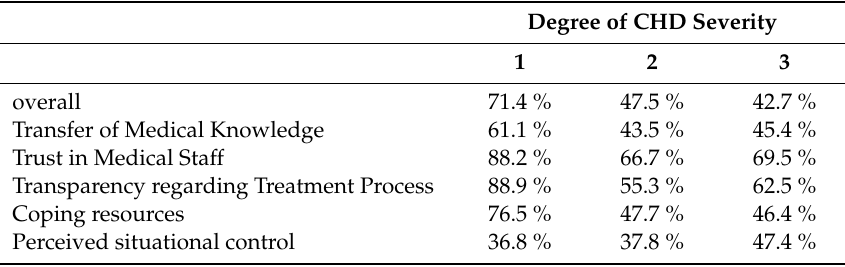
Table 4. Overall counselling success and in all five analytical dimensions depending on the severity of congenital heart disease